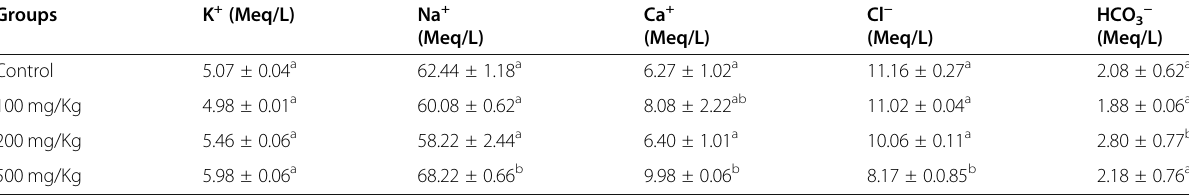
Table 4 Effects of Dennettia tripetala methanol leaf extract on Serum Electrolyte Profile